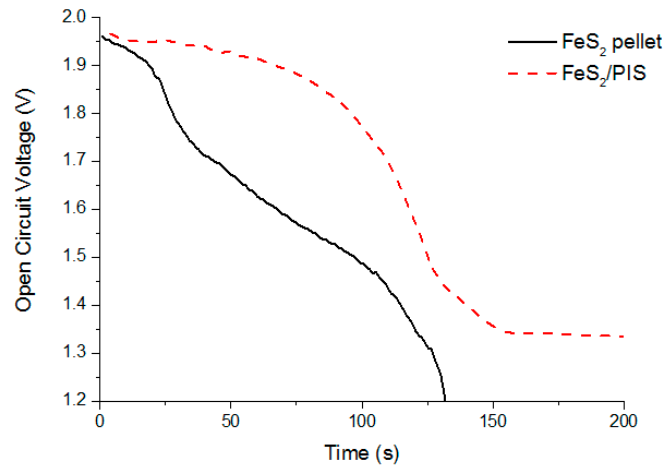
Figure 8. Open circuit voltage changes for the FeS 2 /PIS thin layer cathode and pellet-type FeS 2 .